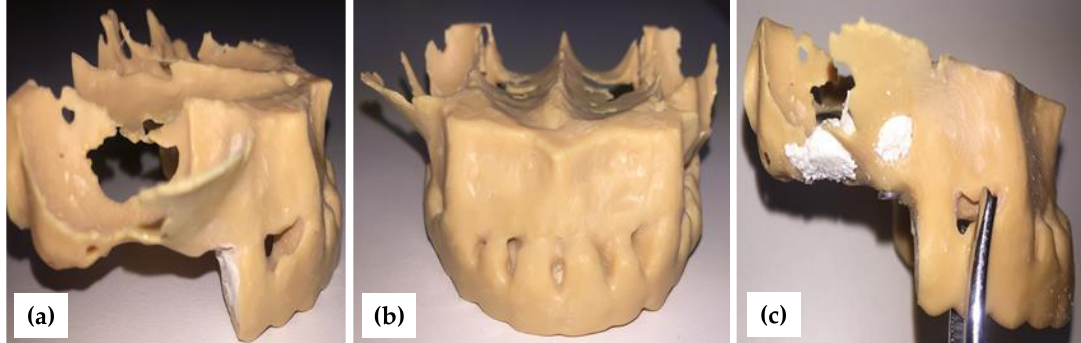
Figure 4. ( a ) 3D-printed model, with ( b ) frontal and ( c ) lateral view.